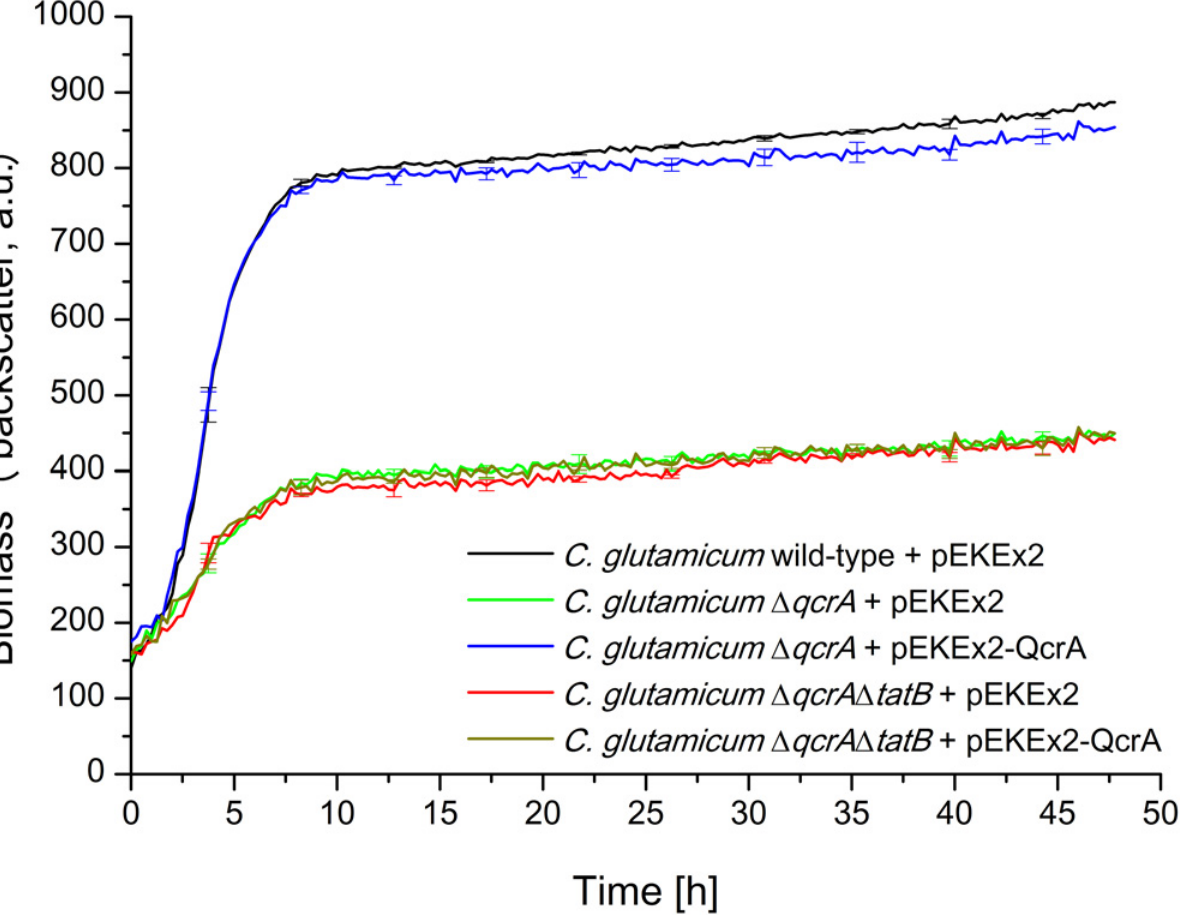
Fig 5. The growth defect of a C . glutamicum Δ qcrA Δ tatB double mutant cannot be complemented in trans by plasmid-encoded QcrA. Cells were inoculated to an OD 600 of 0.5 in 750 μ l BHIS medium containing 100 μ M IPTG and cultivated in 48-well FlowerPlates in a BioLector system for 48 h at 30°C, 1100 rpm under constant 85% relative humidity. Growth of the respective C . glutamicum strains, as indicated in the figure, was monitored as backscattered light (620 nm; signal gain factor 20) in 15 min intervals. The growth curves show one representative experiment of three independent biological replicates. Standard deviations are given for 10 selected time points. a.u.: arbitrary units.